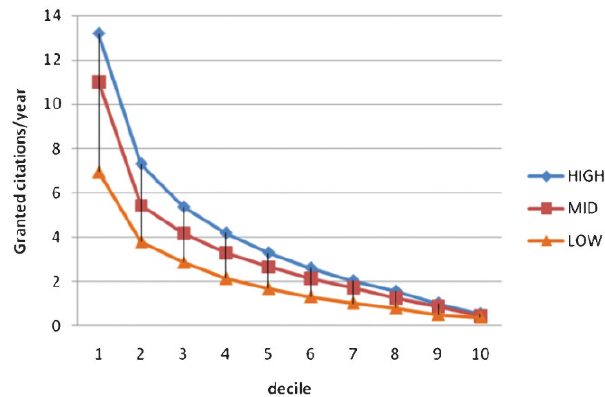
Figure 4 - Probability density functions for granted citations/year in the three major clusters (HIGH, MID and LOW). Density is a highly significant (p , 0.001) function of Impact